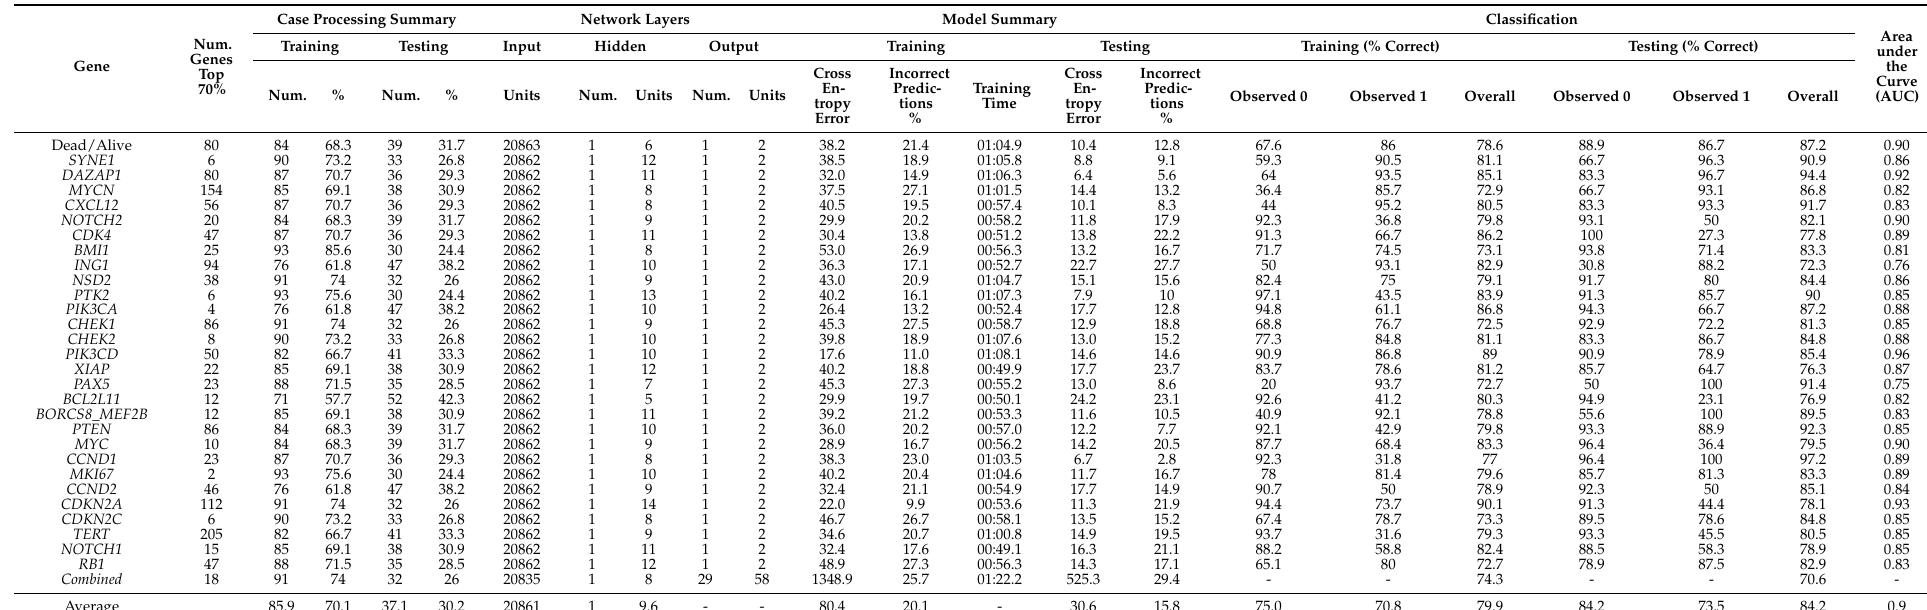
Table A1. Multilayer Perceptron Neural Network Analysis of Mantle Cell Lymphoma (Method